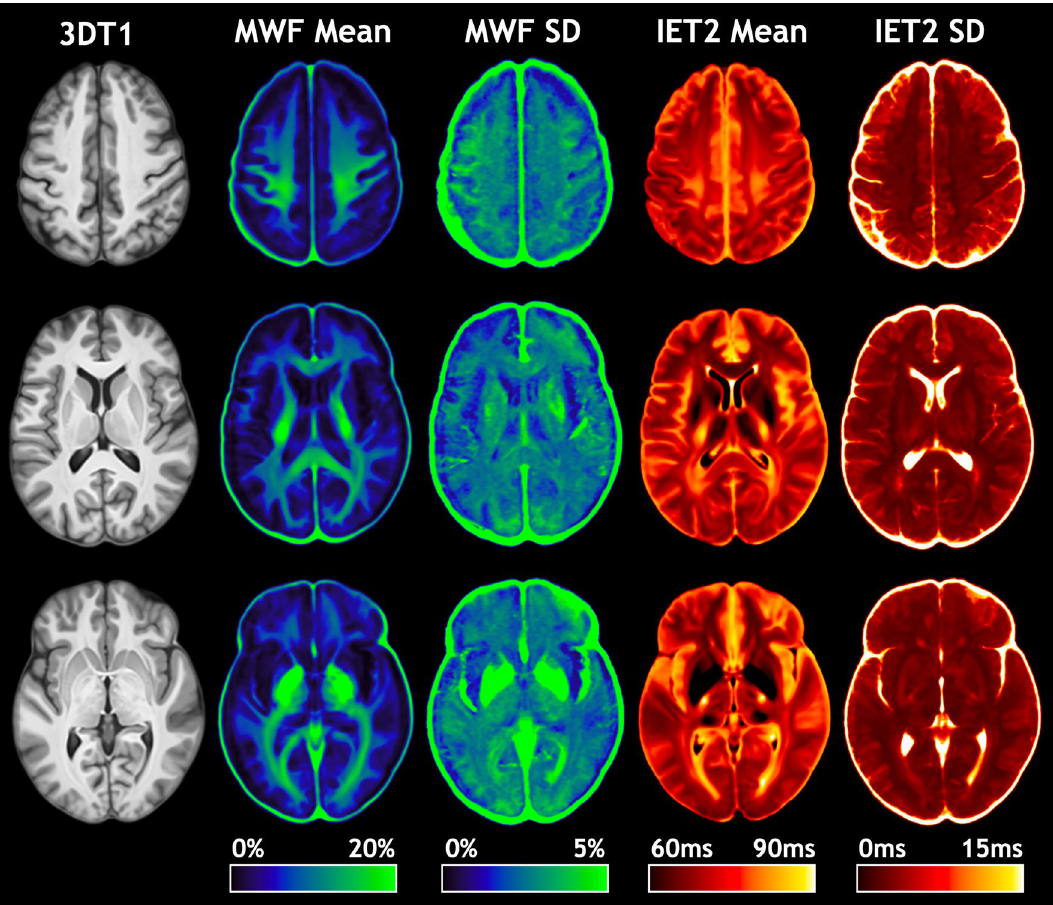
Figure 1. Representative slices of the T 1 -weighted anatomical (3DT1) template, myelin water fraction (MWF) mean and standard deviation (SD) atlases, and geometric mean T 2 of intra- and extra-cellular water (IET2) mean and SD